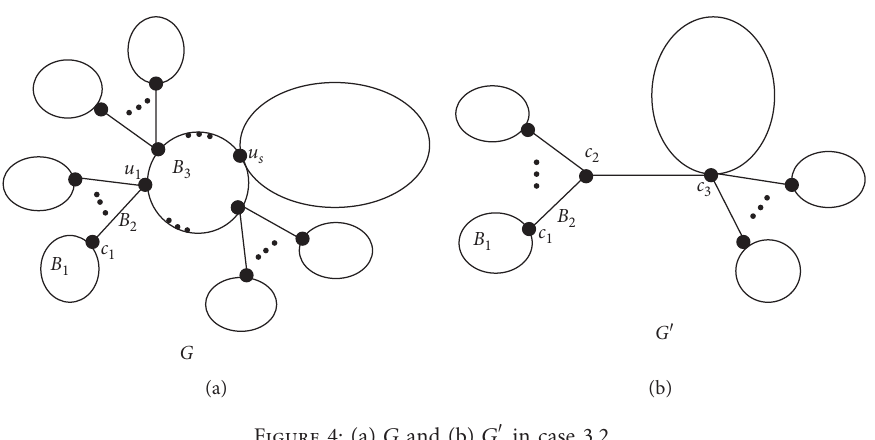
Figure 4: (a) G and (b) G ′ in case